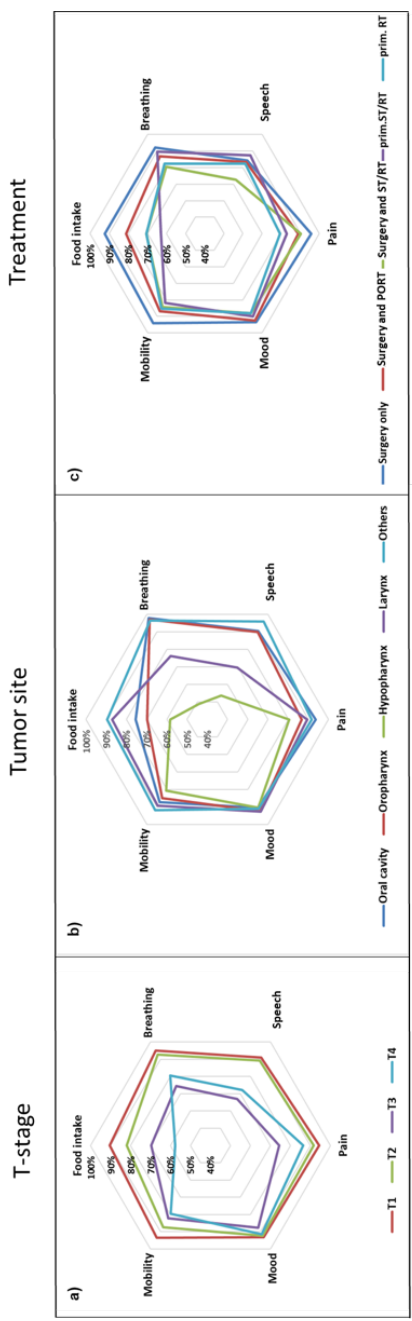
Figure 2. Star plots representing percentage (star axes) of HNC-patients with normal or near- normal functional outcomes (functional integrity) in six functional domains depending on T-stage ( a ), tumor site ( b ), and treatment modality ( c ). The further peripherally, the better (Mobility: neck and shoulder mobility).